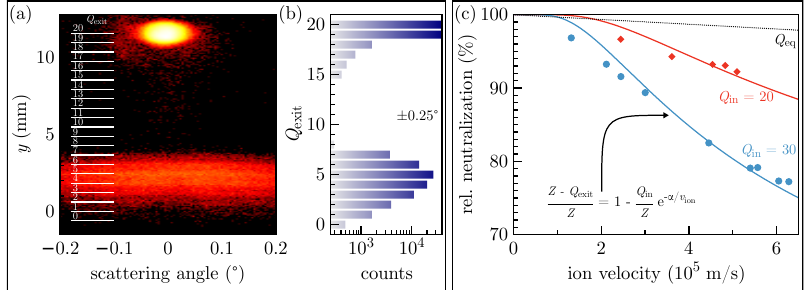
Figure 6. (Color online) ( a ) 2D charge state spectrum of 180 keV Xe 20 + after transmission through a freestanding single layer of graphene with different charge state positions marked by white lines and the scattering angle on the abscissa. ( b ) Integrated charge state spectrum ( a ) for scattering angles between − 0.25 ◦ and +0.25 ◦ (please note the log-scale). ( c ) Relative neutralization mean of the exit charge state distributions (e.g., see ( b )) as function of ion velocity. The equilibrium charge state Q eq is given according to Bohr